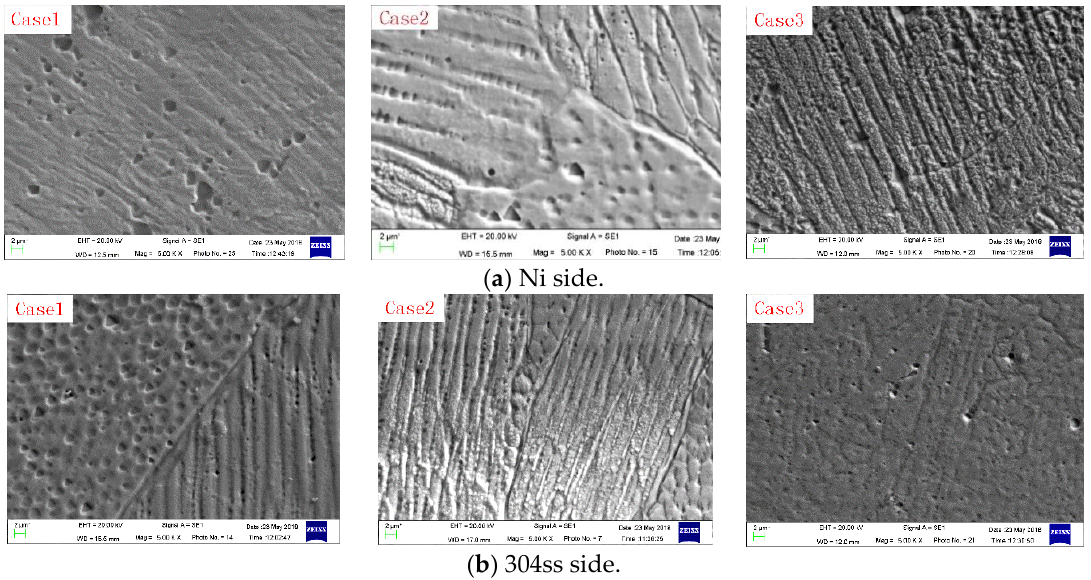
Figure 12. Solidified microstructure under different heat input. ( a ) Ni side. ( b ) 304ss side.